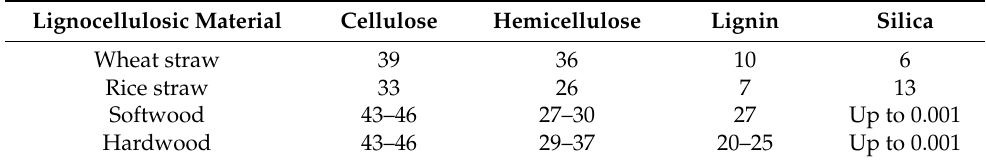
Figure 17. Thermal degradation steps for wood flour (Arbocel C320).